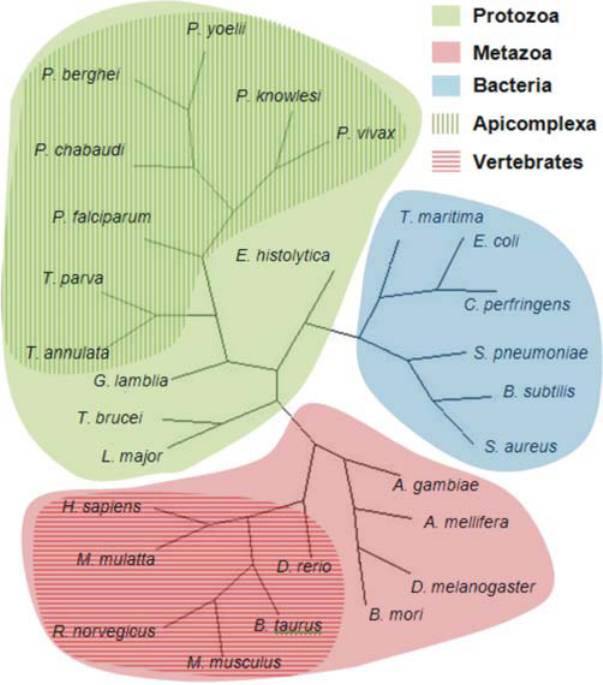
Figure 1. Phylogenetic reconstruction based on orthologous glycerol kinase protein sequences. The unrooted radial tree was generated using the maximum parsimony method. A maximum likelihood tree demonstrated the same topology. Bootstrapping provided . 50% support for each node. The major branches comprising the protozoa, metazoa, apicomplexa and vertebrates were analyzed to identify differences in the patterns of sequence evolution between the four